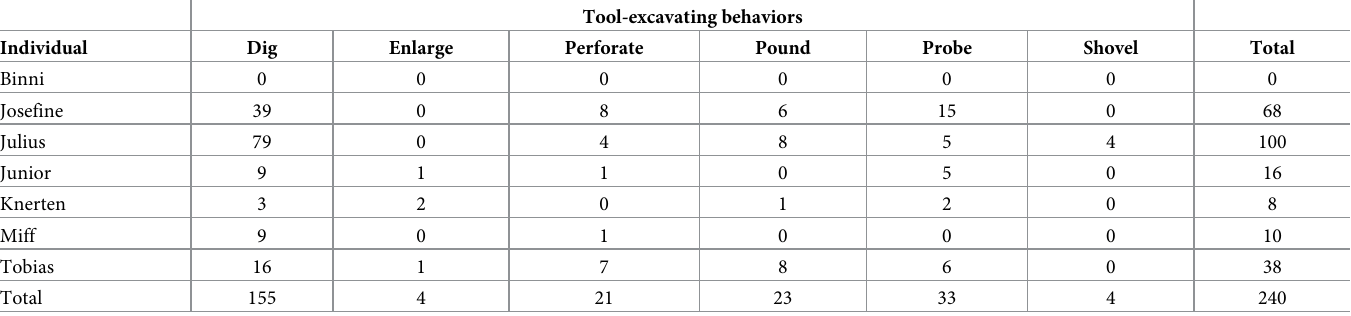
Table 2. Number of events of each excavating behavior performed by each individual during the Compacted Clay Condition of Experiment 1. In one of the events the individual could not be identified.